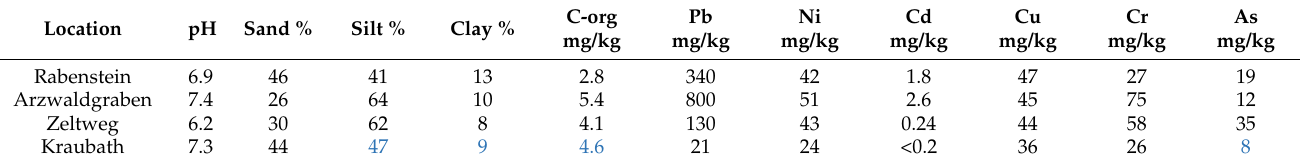
Table 1. Test soils prior to the pot